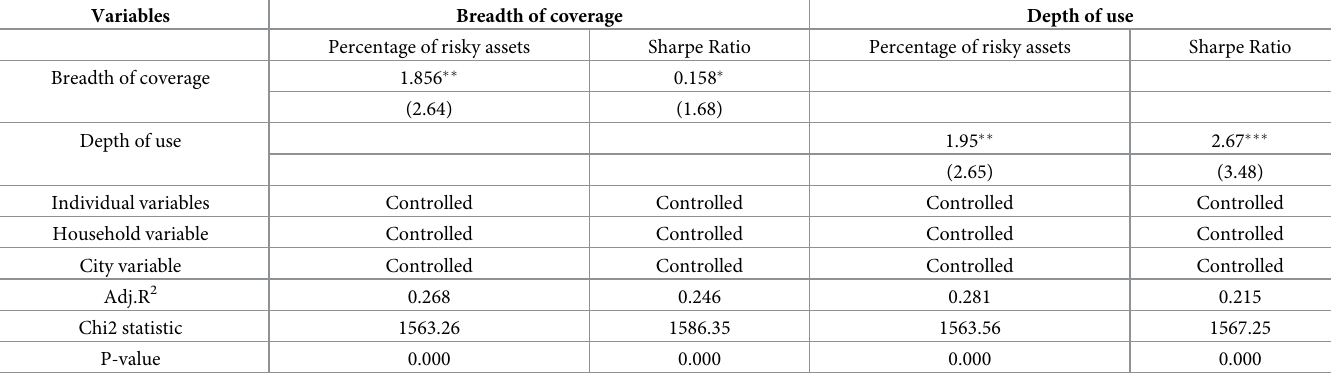
Table 6. Switching to a depth of coverage and breadth of use